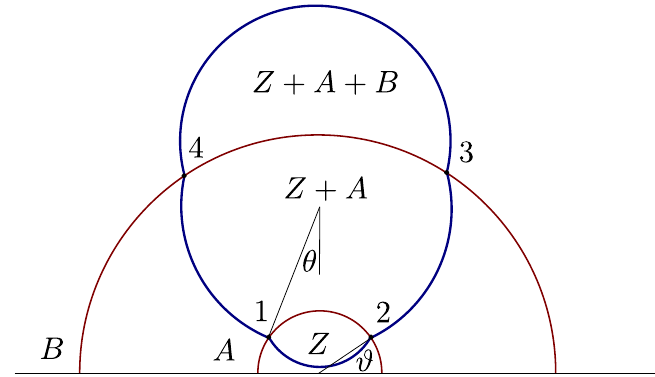
Figure 20 . Bulk diagram for the time ordered four-point